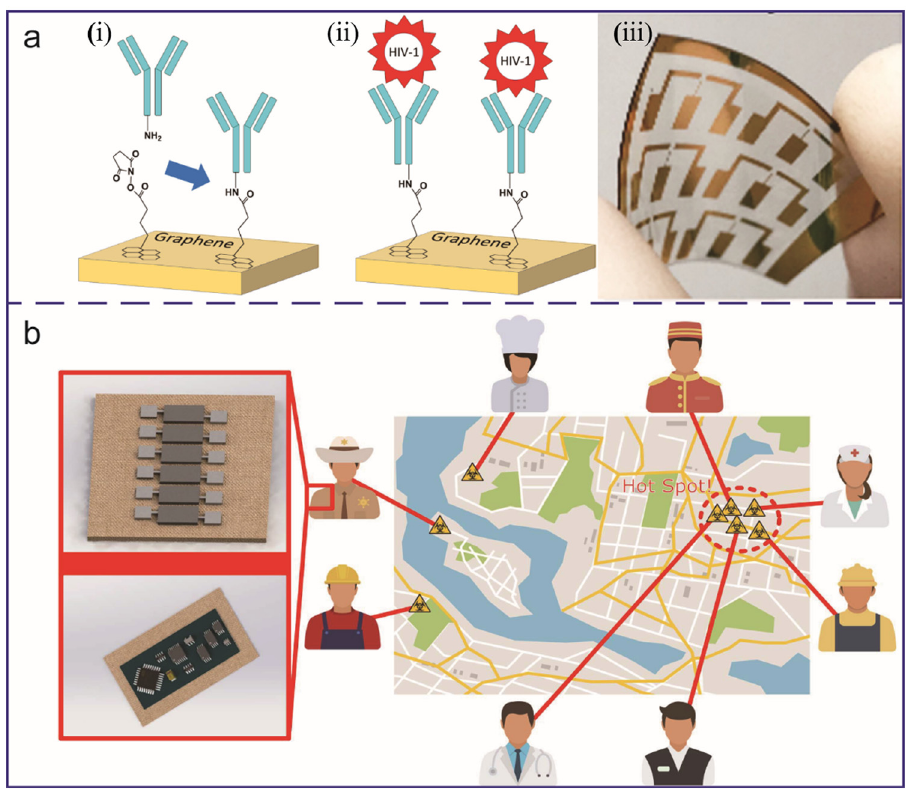
Figure 5: Fabrication and application of graphene sensors. ( a ) ( i ) Binding schematic of the antibody to PASE/graphene by condensation covalent bonding. ( ii ) Detection schematic of virus sensors using the interaction between antibody/PASE/graphene and target HIV - 1 virus. ( iii ) A camera image of a virus sensor [ 49 ] . ( b ) Schematic of envisioned application space for the GO screen printed fl exible impedance biosensors. Sensors arrays mounted on textiles and interfaced with fl exible electronics can report the location of positive cases and identify sources of the outbreak [ 51 ]